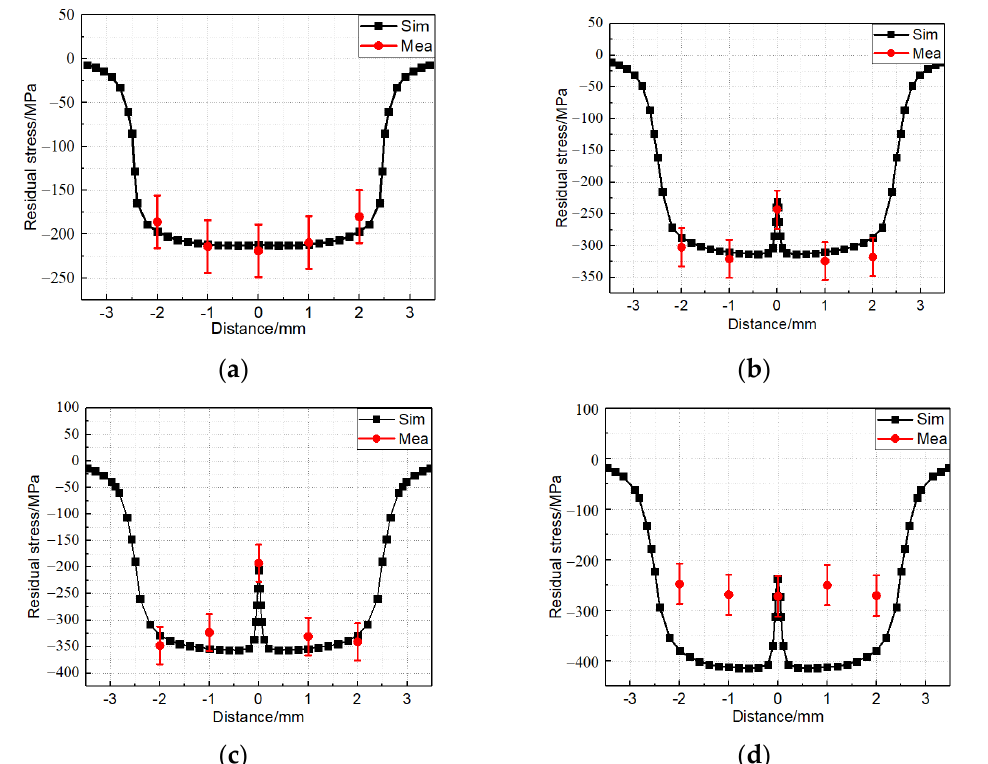
Figure 7. Comparison of experimental and simulated results for residual stresses on the sample surfaces after laser shock under different power densities of ( a ) 1.53 GW/cm 2 , ( b ) 1.98 GW/cm 2 , ( c ) 2.77 GW/cm 2 , and ( d ) 4.07 GW/cm 2 .